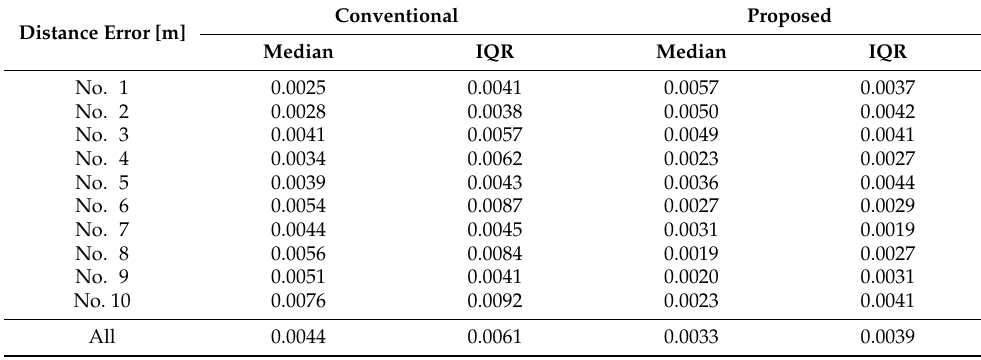
Table 3. Median and interquartile range (IQR) of the heading direction (angular) error—circle pattern. Angular Error